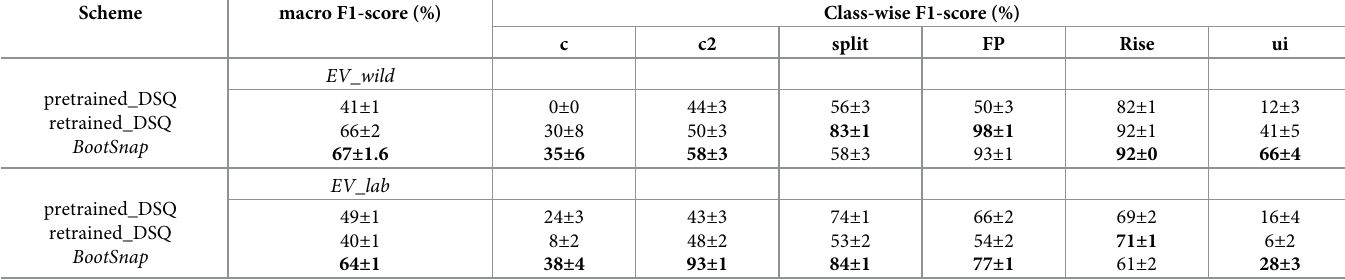
Table 3. Comparison of pretrained DSQ (out of box model), retrained DSQ, and BootSnap performances. The performance metric is calculated based on supervised classification of USVs in EV_wild and EV_lab recordings. The values of macro F1-score (which is the average of F1-score over all classes) and class-wise F1-score (F1-score computed for each class) together with their resampling-based variance estimation are presented.